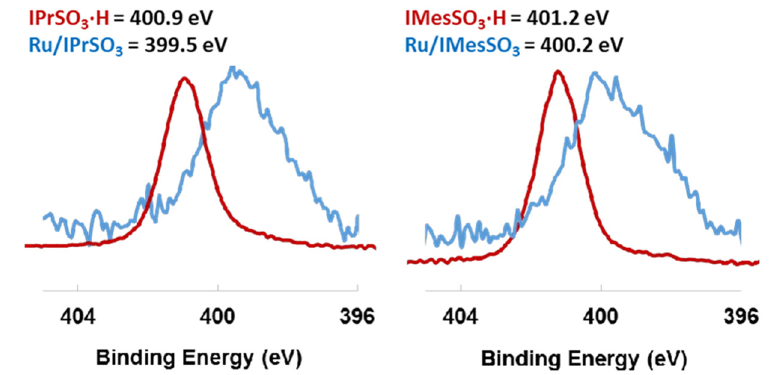
Figure 13. XPS of the N 1s signals of Ru / IPrSO 3 (blue, ( left )), Ru / IMesSO 3 (blue, ( right )) and their corresponding salts IPrSO 3 · H (red, ( left )) and IMesSO 3 · H (red, ( right )). Extracted with permission of reference 48. Copyright 2017 The Royal Society of Chemistry.